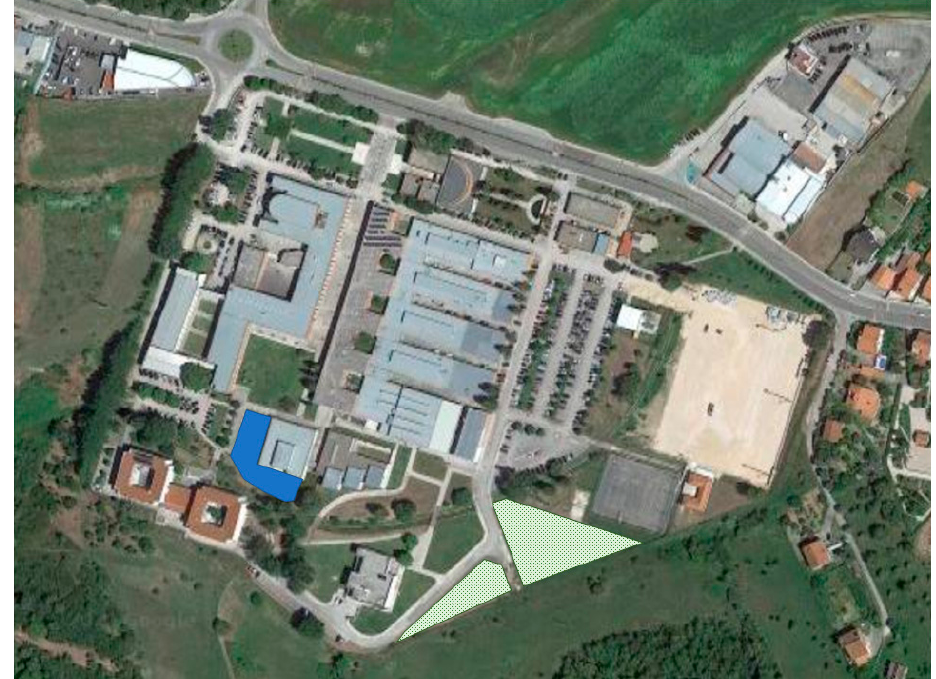
Figure 1. Satellite photo of IPT’s Tomar campus (Google Maps). The dotted green polygons are the areas available for wastewater treatment by constructed wetlands and the microalgae production plant. The blue polygon shows the lake reservoir near the campus library.